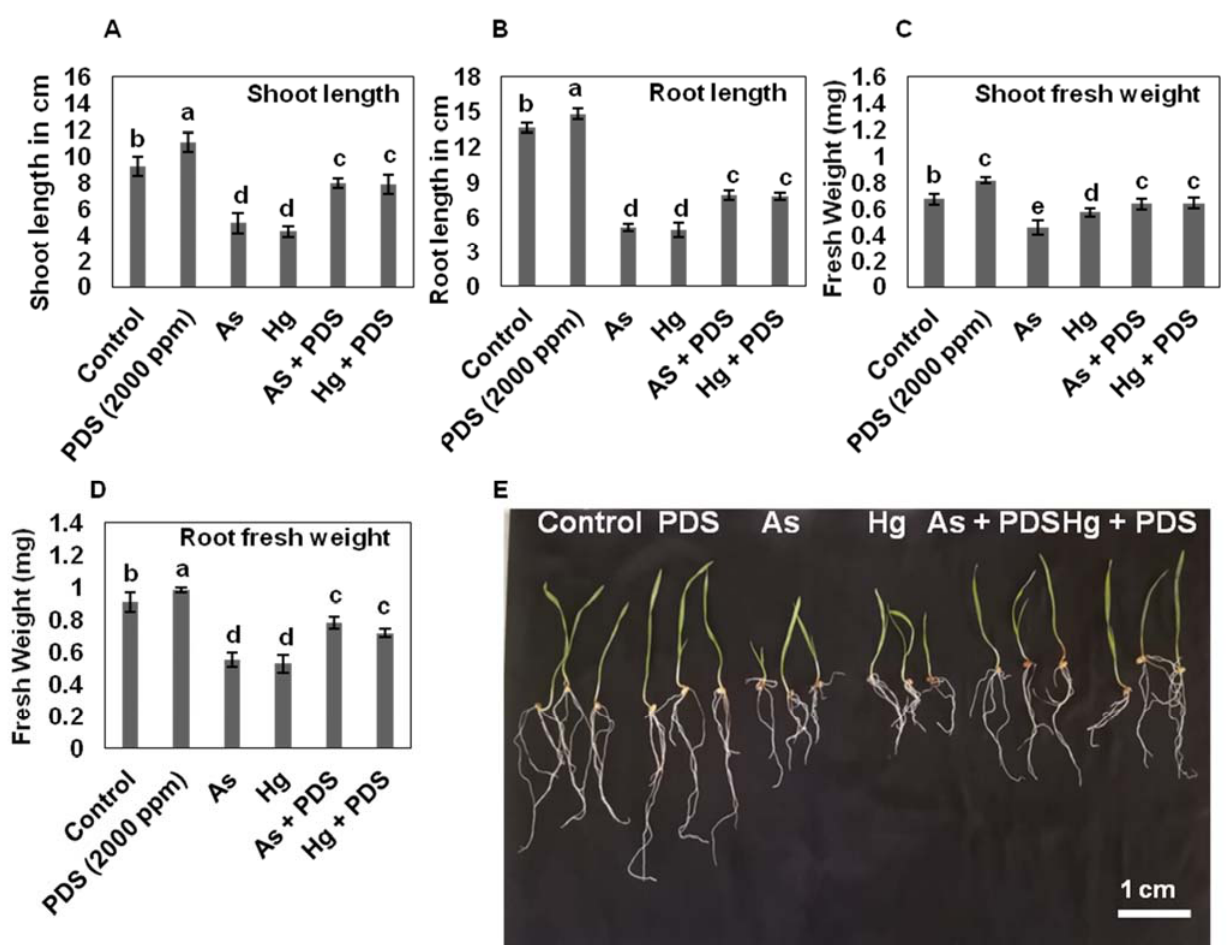
Figure 2. Effect of PDS (2000 ppm), As, Hg alone and in combined form on shoot/root length and fresh weight. The shoot ( A ) and root length ( B ) was measured under As, Hg, PDS, As + PDS and Hg + PDS. ( C ) Shoot ( C ) and root ( D ) fresh weight measured in mg. ( E ) Photograph was taken on day 7. Shoot/root length and fresh weight of ten randomly selected wheat seedlings from each treatment were recorded on day 7. The mean value was obtained from three different experiments performed at different intervals of time. All data were analyzed using one ‐ way ANOVA, with multiple comparisons using LSD test at a significance threshold of p ≤ 0.05 ( n = 10). The different lowercase letters represent homogeneous subsets and indicate the statistical significance according to Fisher’s LSD at level p ≤ 0.05.